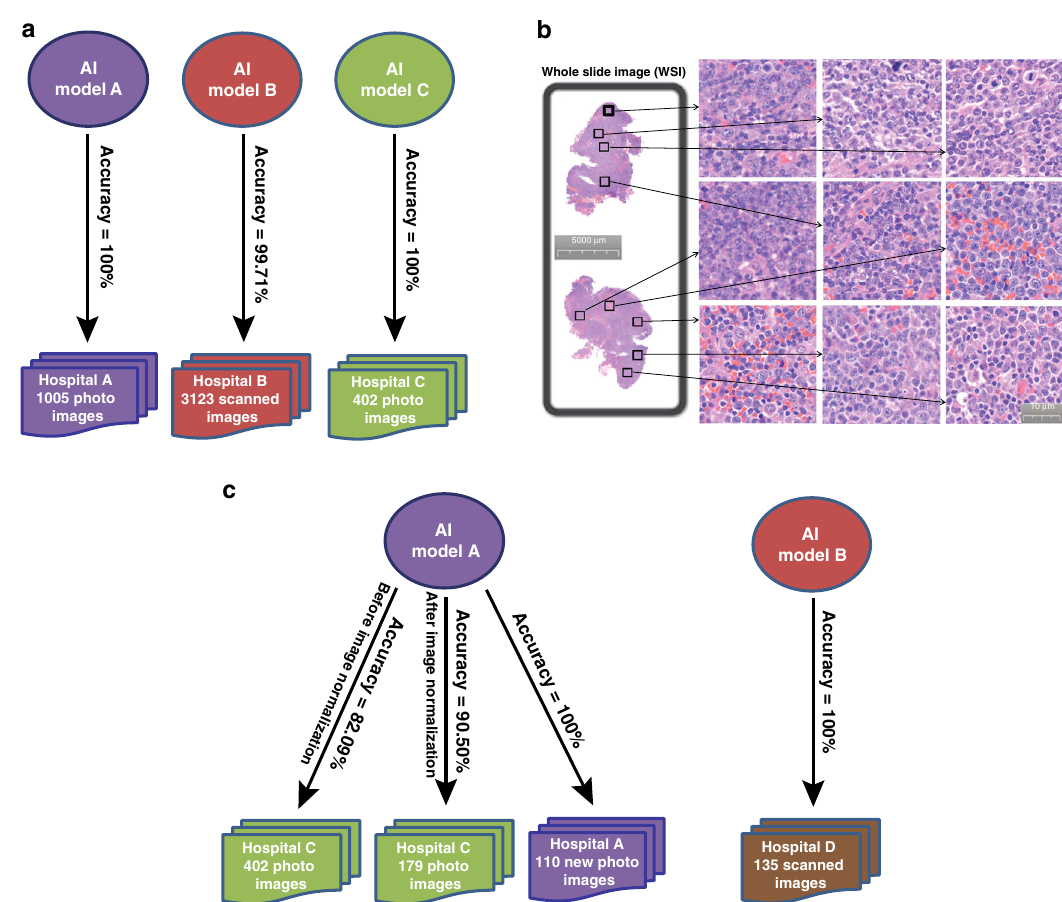
Fig. 3 A high diagnostic accuracy of our AI models with the use of smaller datasets. a Hematoxylin and eosin (H&E)-stained formalin- fi xed paraf fi n- embedded tissue sections prepared from lymph nodes of DLBCL and non-DLBCL patients from four unrelated hospitals (hospitals A, B, C)